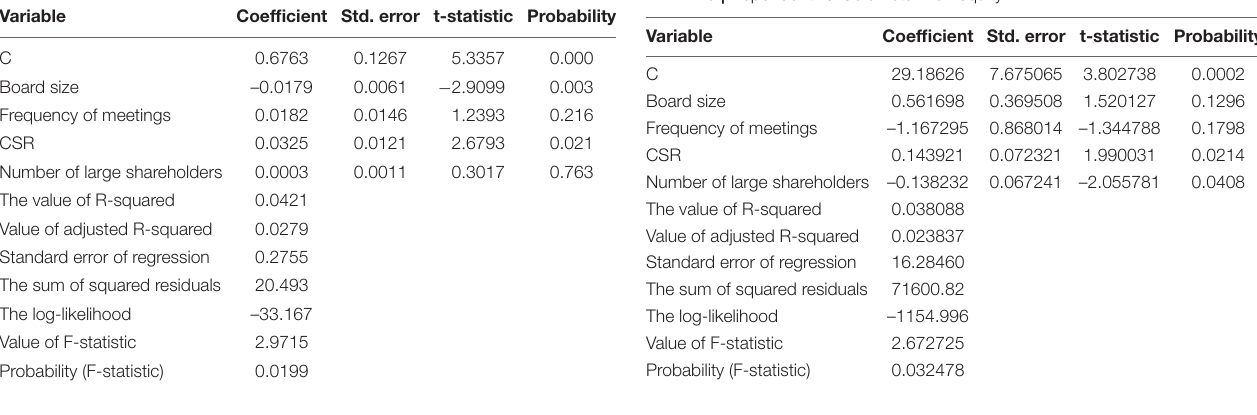
TABLE 5 | Dependent variable: return on